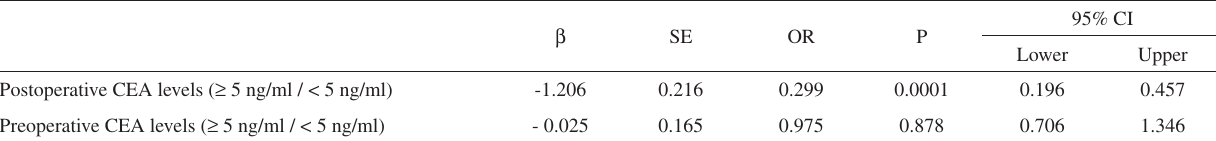
Table 6 - Multivariate analysis of factors releated to survival in CRC patients